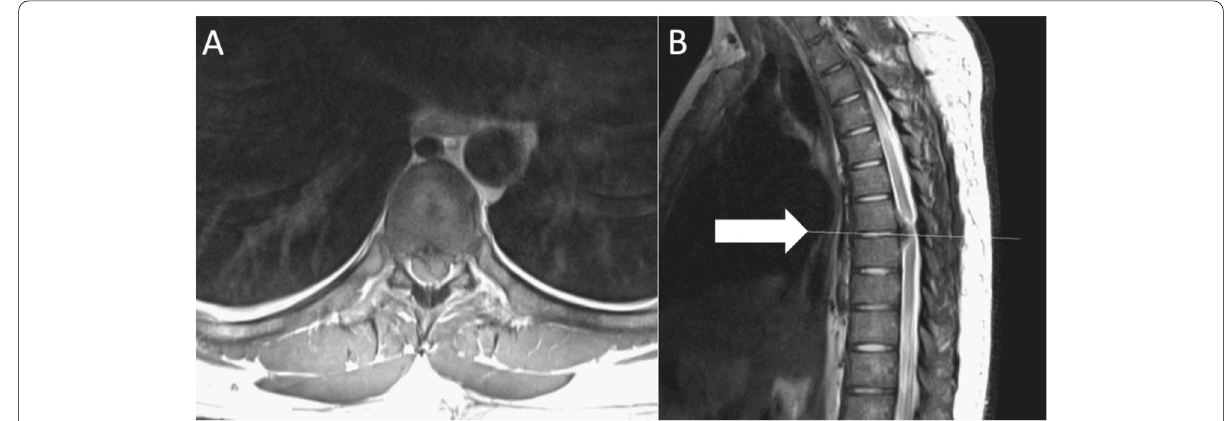
Fig. 1 Preoperative T2 weighted MRI in ( A ) axial and ( B ) sagittal views, indicating the level of herniation